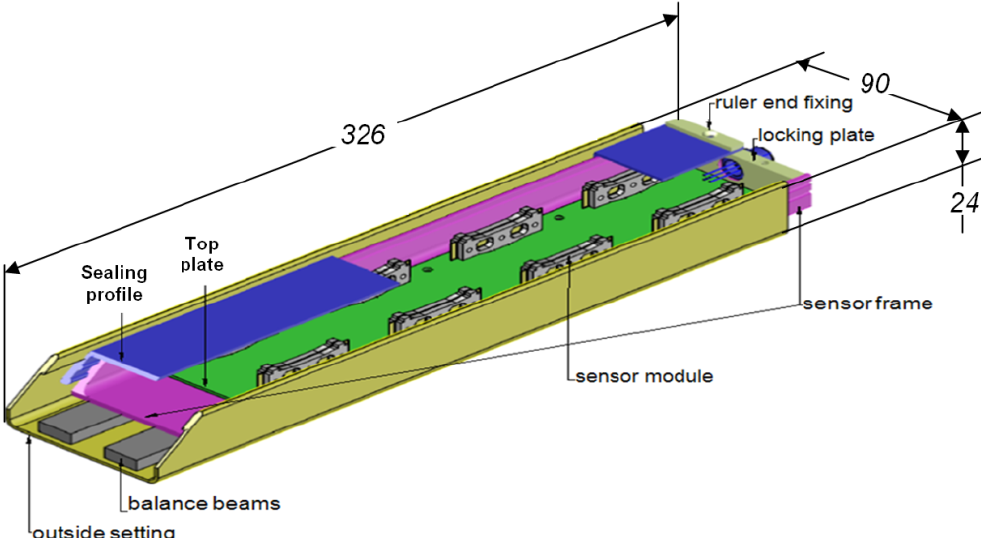
Figure 2. A WIM sensor